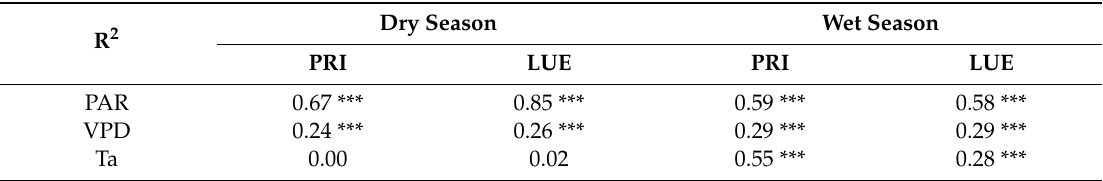
Table 2. Comparison of responses of PRI and LUE to environmental factors in the dry season and wet season. R 2